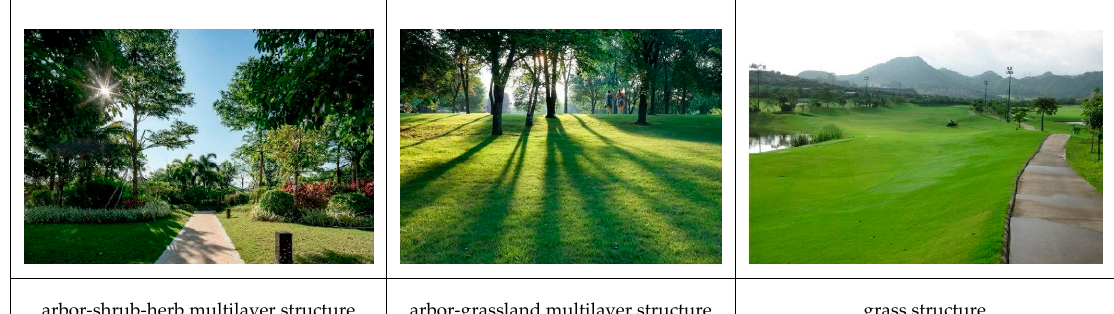
Figure 8. Three types of urban green space.